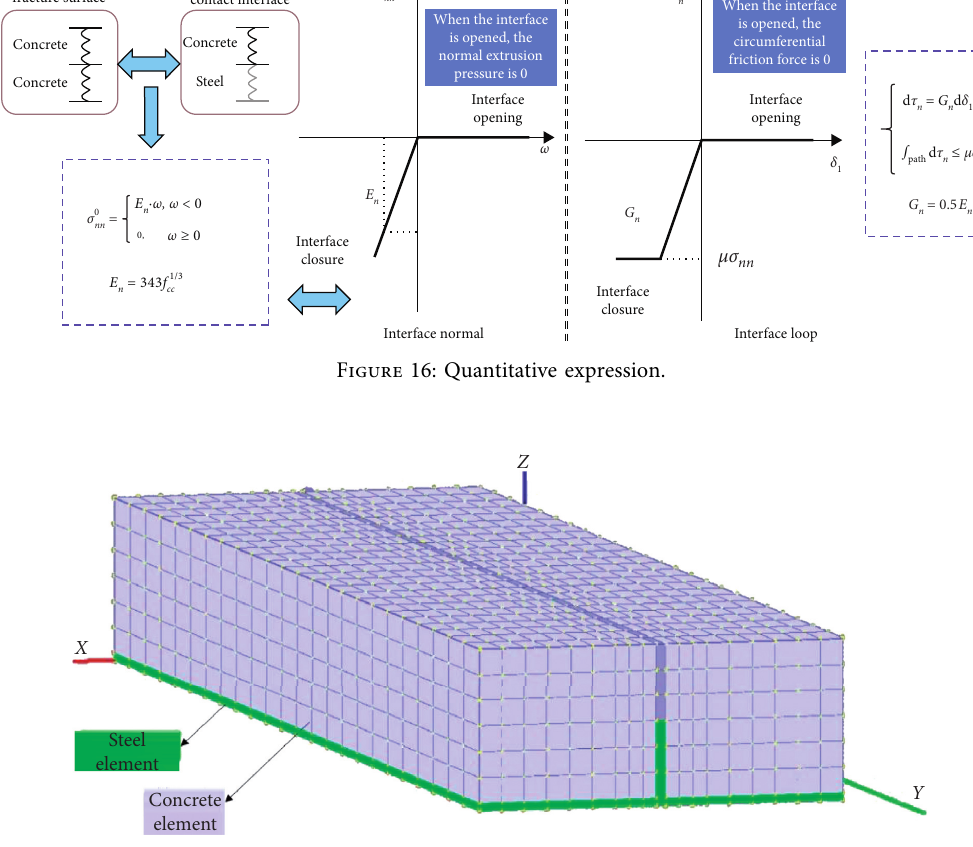
Figure 17: FEM simulation model.